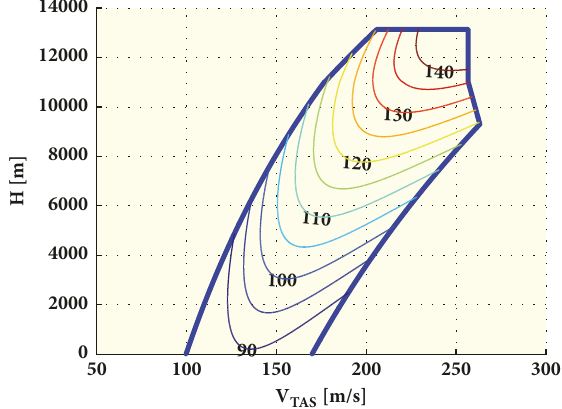
Figure 12: Specific range (SR [m/kg]) of a jet passenger aircraft.